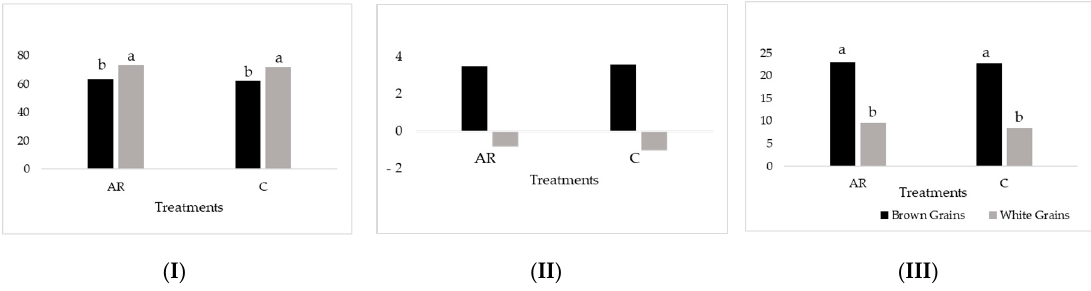
Figure 3. Average colorimetric parameters ± standard deviation (n = 4) of brown and white rice grains of Oryza sativa L. varieties Ariete (AR) and Ceres (C) at harvesting. Labels ( I ), ( II ), and ( III ) represent L*, a*, and b* parameters, respectively. Letters a and b indicate significant differences among grains in each variety ( p ≤ 0.05).